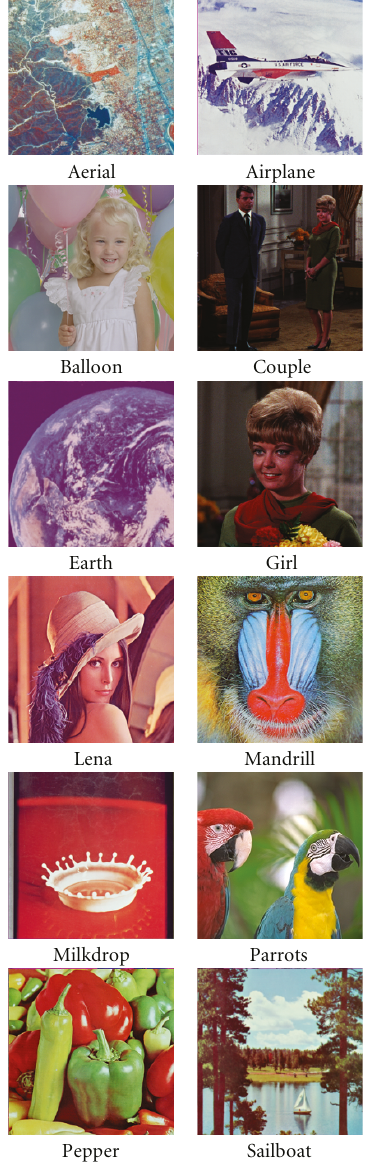
Figure 7: Watermarked images (MTF). Figure 8: Watermarked images